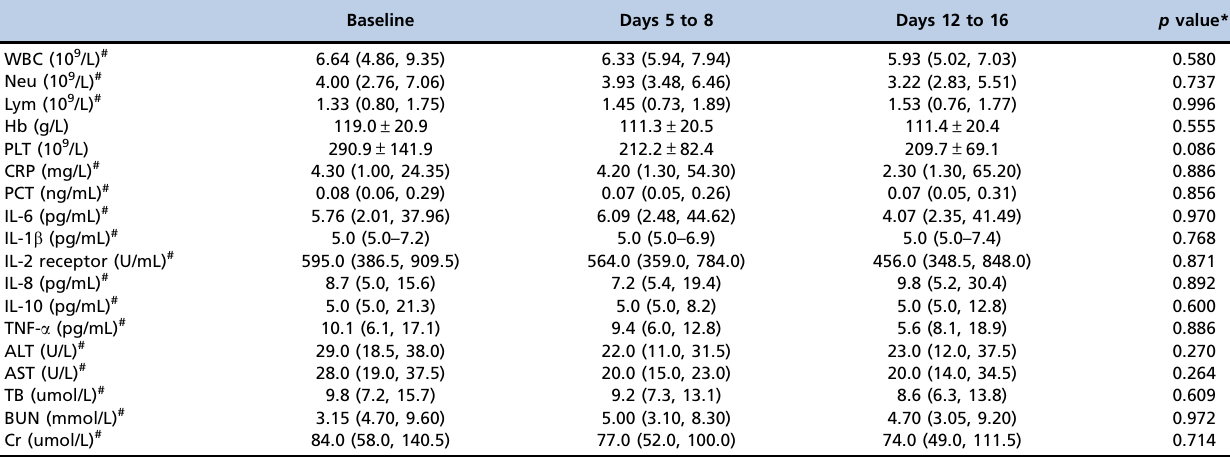
Table 4 - Comparisons of biomarker levels at three time points in the control group. Baseline Days 5 to 8 Days 12 to 16 p value*